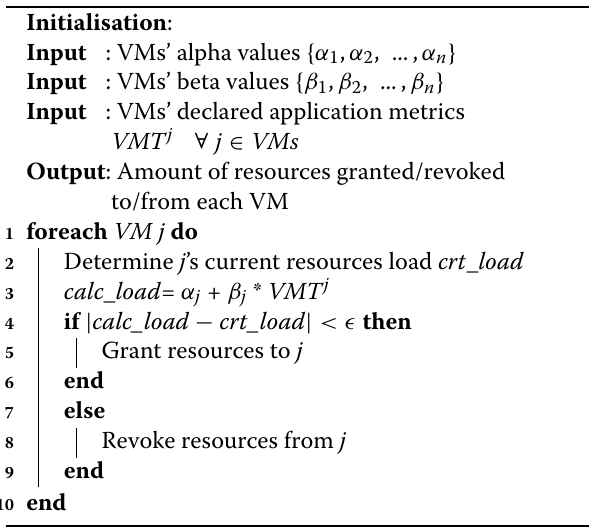
Algorithm 3: Verification and Resources Allocation